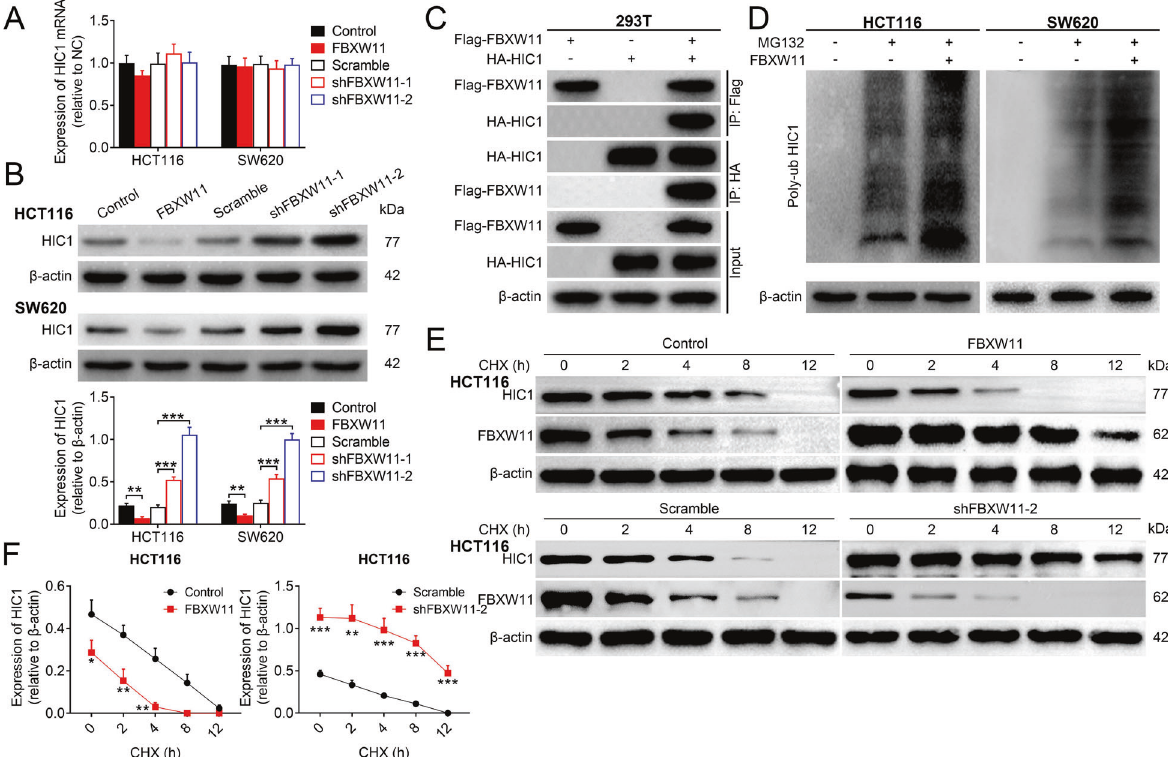
Fig. 4 Effect of FBXW11 on the stability of HIC1. A , B HCT116 and SW620 cells were transfected with recombinant lentiviral vectors carrying FBXW11, shRNAs targeting FBXW11, or corresponding controls. The A mRNA and B protein levels of HIC1 in transfected CRC cells were determined by qRT-PCR and western blotting, respectively. C HEK-293T cells were transfected with FLAG-tagged FBXW11 or HA-tagged HIC1, or both for 48 h. Then cells were stained antibodies against FLAG tag or HA tag. The immunoprecipitated proteins were analyzed by western blotting. D The ubiquitination level of HIC1 in transfected CRC cells was examined by treating them with 20 μ M of MG132 for 3 h. Cells were then mixed with conjugated beads followed by immunoprecipitation with anti-poly-ubiquitin antibody. E Transfected HCT116 and SW620 cells were treated with 10 µg/mL of CHX. The protein expression of HIC1 was analyzed by western blotting at 0, 2, 4, 8, and 12 h after treatment. F The quali fi cation curves of HIC1 expression in both cells lines at different time points were plotted. Student ’ s t -test and ANOVA followed by Bonferroni ’ s post hoc test were used for statistical comparisons between two groups or among multiple groups,